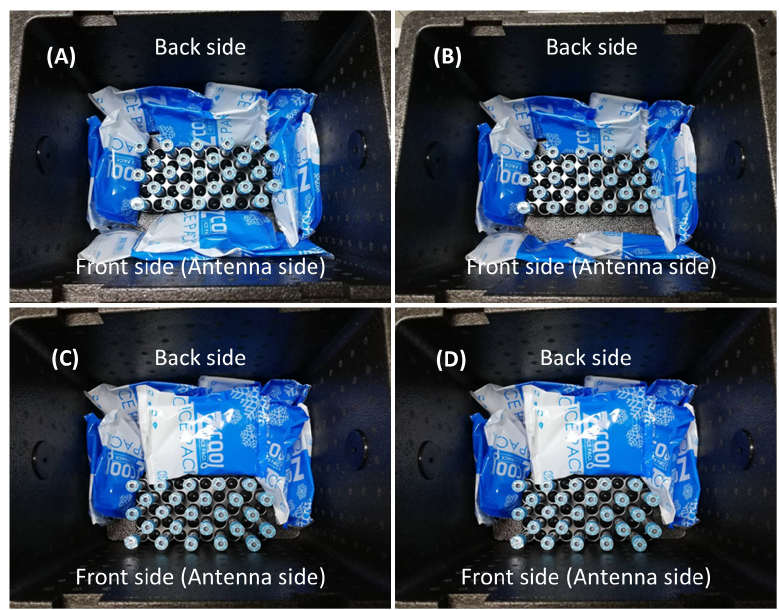
Figure 7. Experiment determining the ice bag’s position inside the transport box. 25 non-liquid tubes and 10 ice bags at 4 sides ( A ), 25 non-liquid tubes and 9 ice bags at 4 sides ( B ), 25 non-liquid tubes and 9 ice bags at 3 sides ( C ), and 25 liquid (water) tubes and 9 ice bags at 3 sides ( D